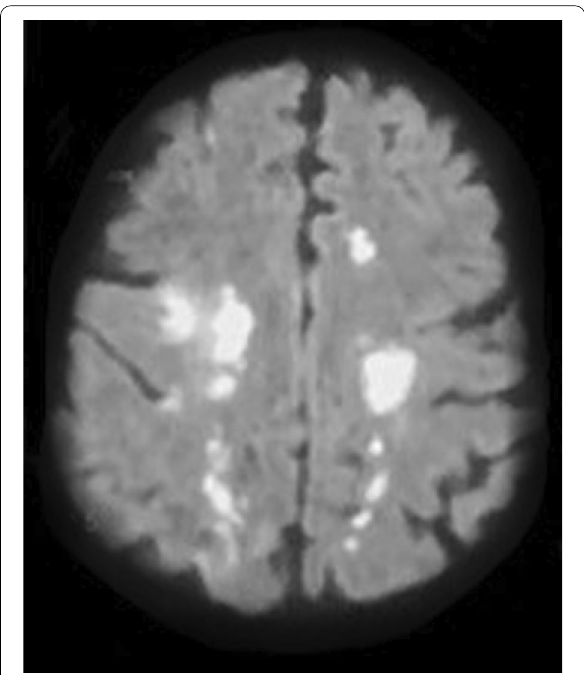
Fig. 1 Bilateral cortical border zone (watershed) infarcts as evident by restricted diffusion